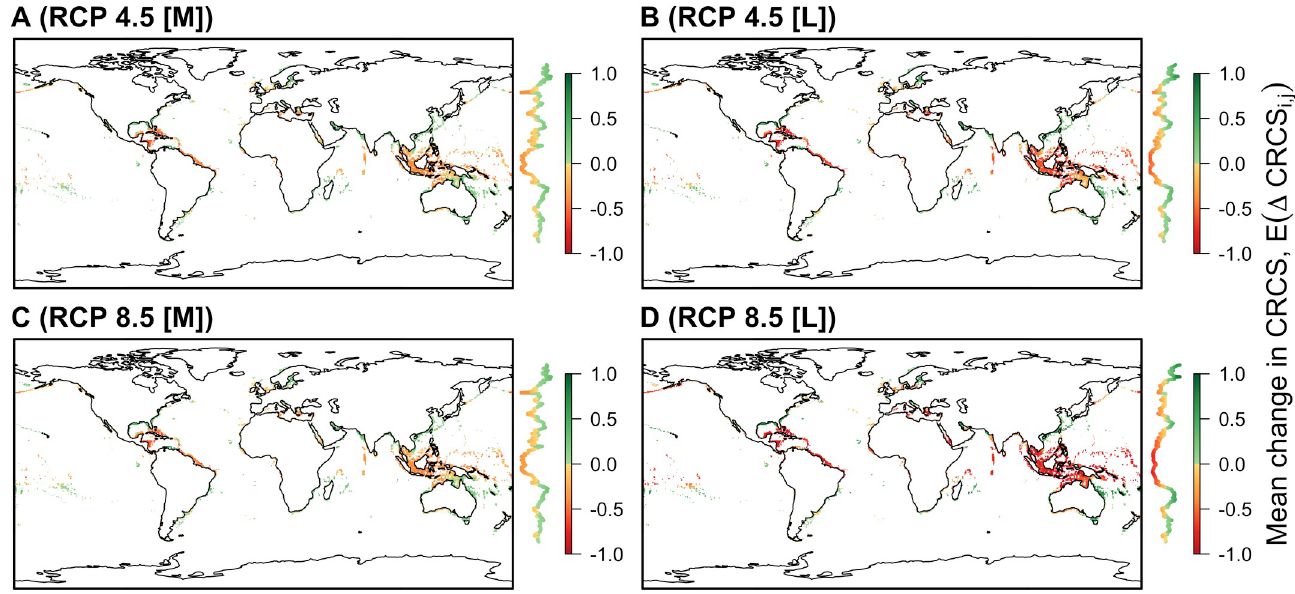
Fig 3. The mean predicted change in the index of thermal habitat suitability, E( Δ CRCS i,j ), under future sea surface temperature (SST) change for two climate experiments (RCP 4.5 and 8.5) over mid-century (M) and late-century (L) timescales. In each 0.5˚ grid cell, the mean predicted change in the CRCS, calculated over all species whose predicted distributions overlap with that cell, is shown. Predictions are only shown within Exclusive Economic Zones. Adjacent to each map, the coloured line shows the mean E( Δ CRCS i,j ) across all cells in each latitudinal band, following same colour scheme as for the map, with lower values (in red) to the left and higher values (in green) to the right. Background coastline data are from Natural Earth (public domain).